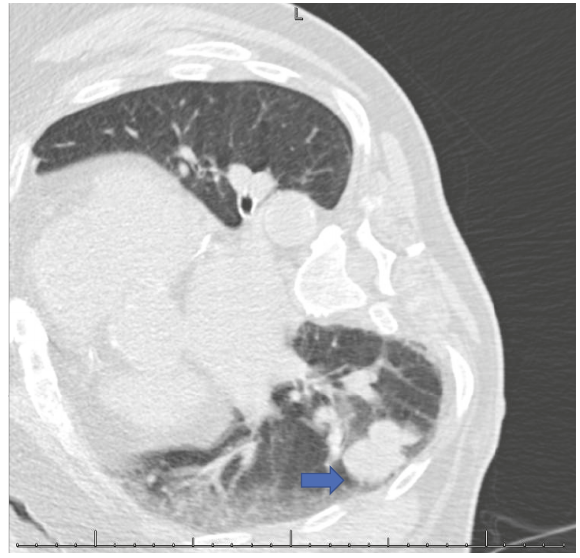
Figure 2: Chest CT. Arrow: 3.2x2x4.3 cm mass in the superior segment of the right lower lobe.